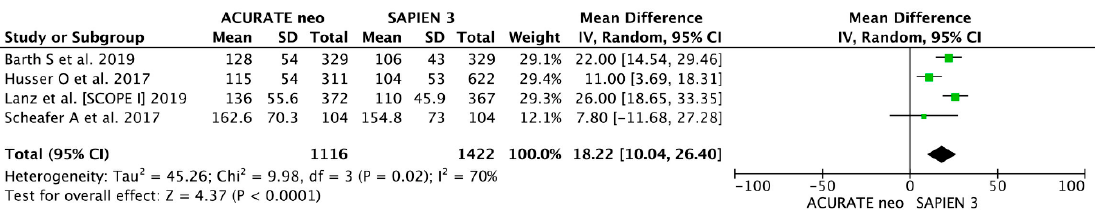
Figure A3. Procedural outcomes. Detailed analysis of individual weighted mean differences (MDs) with corresponding 95% CIs on contrast volume used for the comparison of ACURATE neo vs. SAPIEN 3.